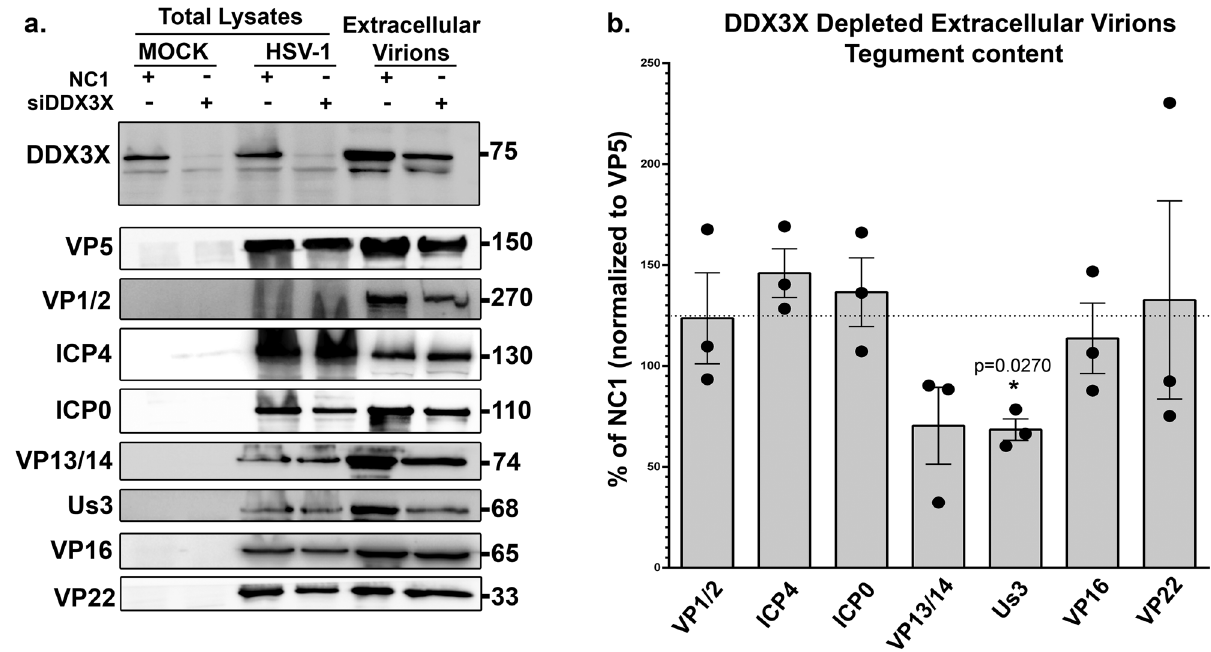
Fig. 9 DDX3X promotes optimal pUs3 virion incorporation. a HeLa cells were grown on 245 mm plates and treated with control non-targeting NC1 or siDDX3X for 48 h. Transfected cells were mock-treated or infected with wild-type strain 17 + virus. At 24 hpi, supernatant containing the mature virions were collected and concentrated at 60,000 x g. They were next analyzed on 5 – 20% gradient SDS-PAGE and Western blotting, using a panoply of antibodies targeting various viral tegument proteins. Total lysates of the same cells collected in lysis buffer and analyzed in parallel served as negative (mock cells) and positive (infected cells) antibody controls. DDX3X depletion in the cell and virions was con fi rmed by probing DDX3X in the same samples. b Image Lab version 5.0 was then used to quantify the Western blots (note that detection of the proteins was done on an instrument with a 4-log linear range, not on X-ray fi lm). VP5, which served as a loading control, was used to normalize the data of the infected samples. The bars indicate means of three independent experiments and the standard error of the means (bilateral Student T -tests; * p < 0.05). pU S 3 was the only statistically different tegument in the DDX3X depleted